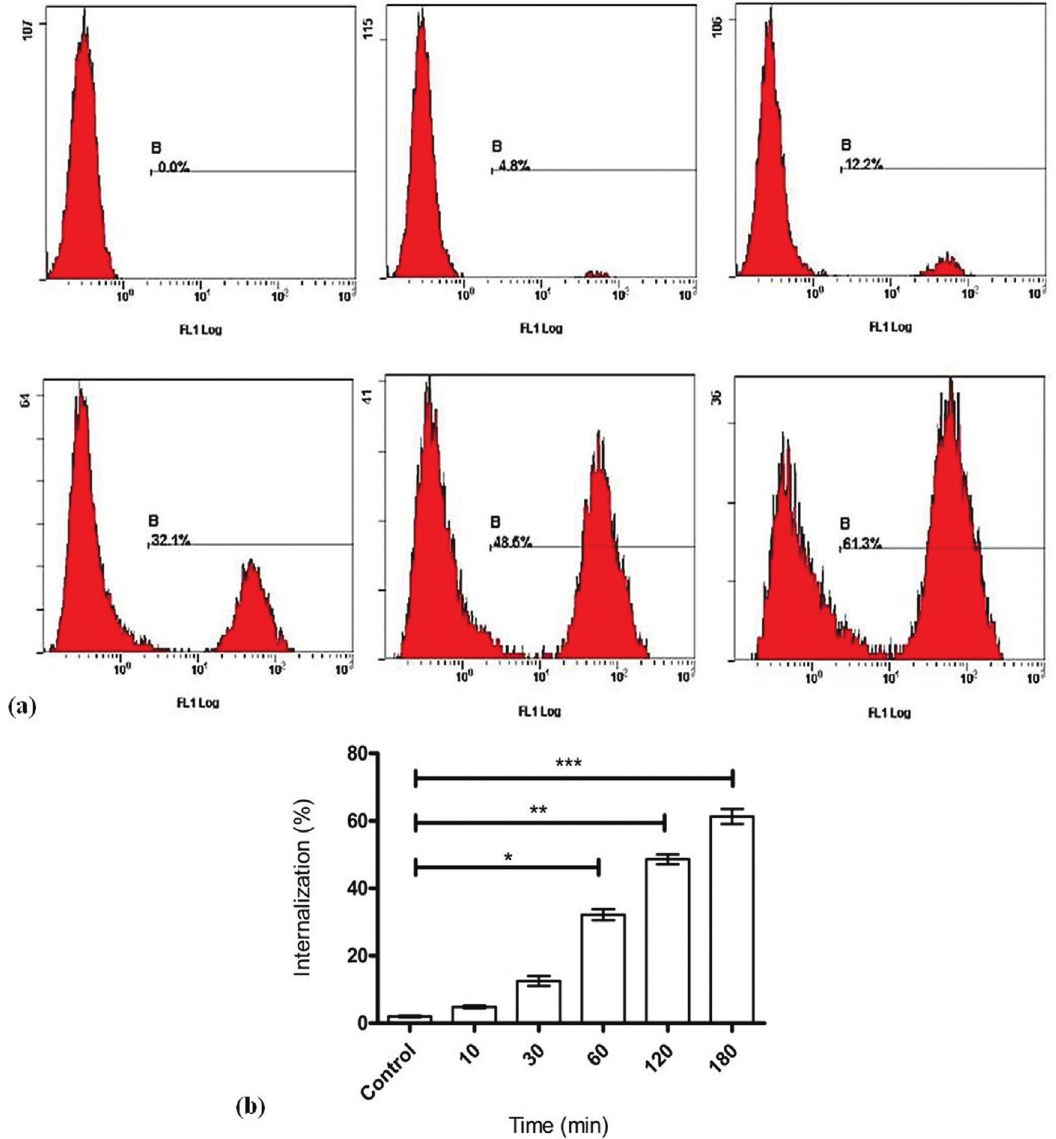
Figure 8 - Intracellular trafficking of the conjugated drug through Flow-Cytometry analysis. (a): Six different panels show the intracellular trafficking mechanism of the scFv-PD-L1 drug against A549 hepatocellular carcinoma as a model. The flow rate was conducted through Flow Cytometry analysis. The upper panel from left to right indicates 0 minutes, 10 minutes and 30 minutes of incubation. The lower panel from left to right shows 1 hour, 2 hours and3hoursofincubationtime.Thepercentincreasewascalculatedthatshowselevatedtraffickingmechanismsafter2hoursandreachesamaximumat3 hours of incubation. (b): After each time point, the proportion of internalized drug conjugates was measured. Data were generated from three independent experiments. One-way ANOVA was used to analyze the maximum trafficking studies, ***p<0.001, **p<0.01,